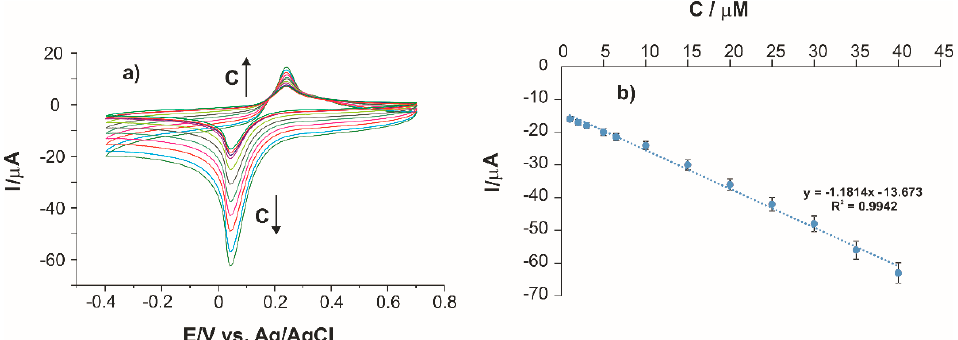
Figure 6 . ( a ) CV of PB/SPCE immersed in diosmin solutions with various concentrations (in the range of 1–40 µM); ( b ) calibration curve based on the cathodic peak .